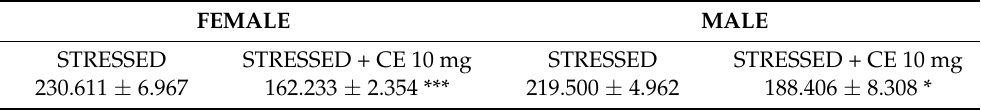
Table 1. Effect of CE-123 administration (10 mg/kg) before each acquisition session on D1 receptor expression in the hippocampus of MS male and female adolescent (PND34) rats. Data represent mean ± SEM (N = 5 rats/group). The concentration of proteins was calculated from a standard curve and expressed as ng/mg of protein. * p < 0.05; *** p < 0.001 vs. stressed